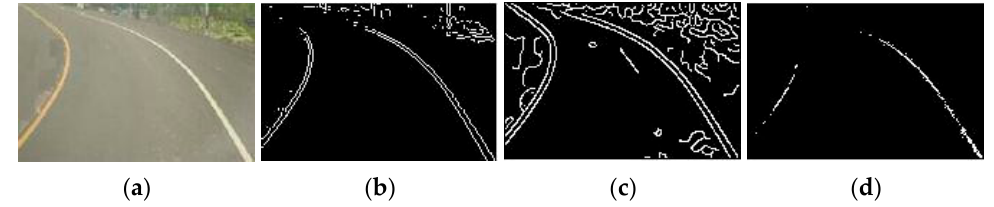
Figure 5. Test results of different detectors. ( a ) Original image, ( b ) Sobel detector, ( c ) Prewitt detector, and ( d ) Canny detector.